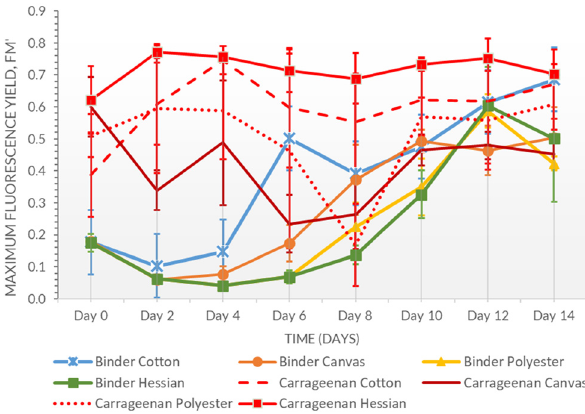
Figure 9: Chlorophyll fl uorescence levels of the kappa – carrageenan on the following textiles: cotton ( mean StDev = 0.134 ) , canvas ( mean StDev = 0.086 ) , polyester ( mean StDev = 0.144 ) , hessian ( mean StDev = 0.043 ) , and Auro paint 3D printed samples on tex - tiles: cotton ( mean StDev = 0.056 ) , canvas ( mean StDev = 0.053 ) , polyester ( mean StDev = 0.037 ) , hessian ( mean StDev = 0.060 ) over a 14 day